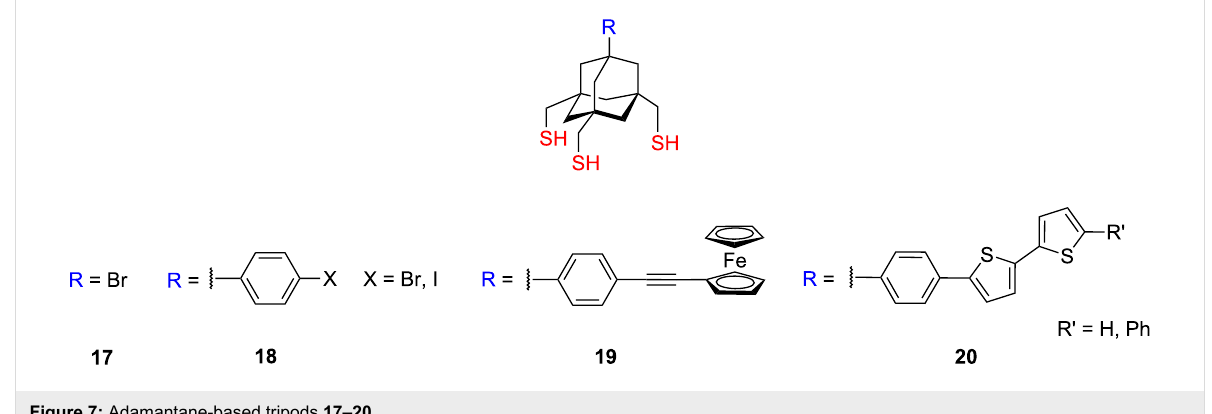
Figure 7: Adamantane-based tripods 17–20 .